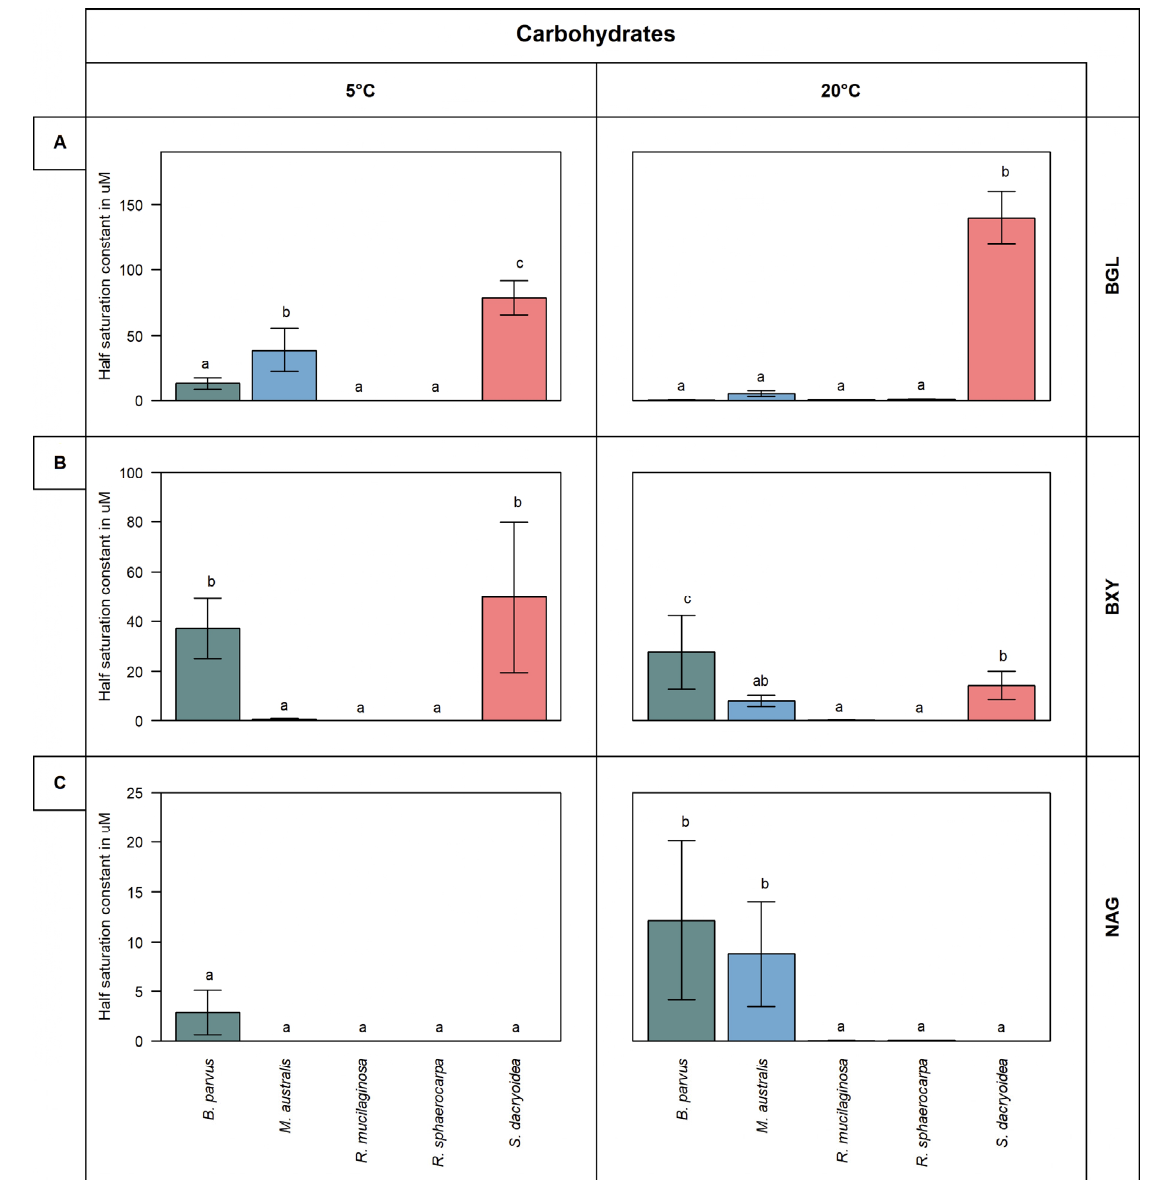
Figure 3. K m in µ M obtained from the total enzymatic activity for the substrates representing carbohydrates, such as ( A ) β -glucosidase (BGL), ( B ) β -xylosidase (BXY), and ( C ) N -acetyl- β -D- glucosaminidase (NAG) of the five marine fungal isolates ( B. parvus, M. australis , R. mucilaginosa , R. sphaerocarpa , and S. dacryoidea ). Measurements were performed at 5 ◦ C and 20 ◦ C in the exponential phase. According to Tukey’s HSD, bars denoted by a different letter (a, b, and c) are significantly different ( p < 0.05), whereas bars denoted by a common letter (ab) are not significantly